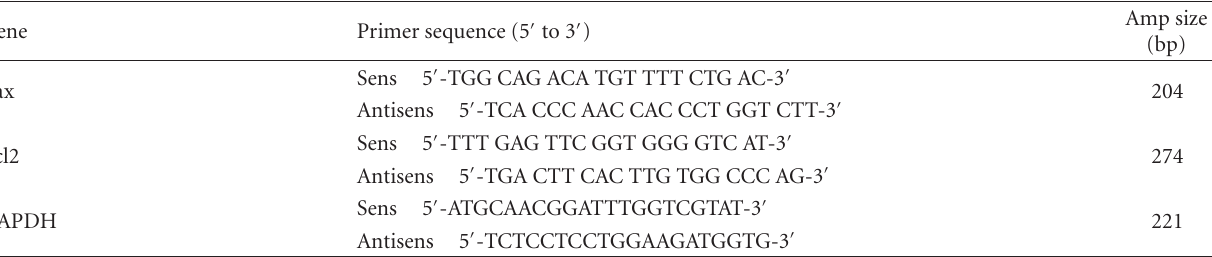
Table 2: Description of oligonucleotide primer pairs used in PCR